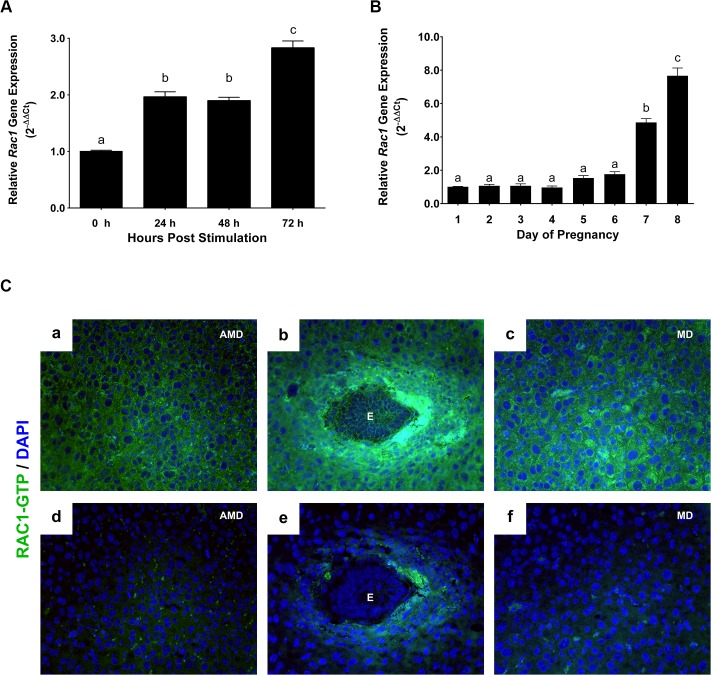
Rac1 is induced in the uterus during early pregnancy.
(A) Induction of Rac1 mRNA in the uterus during experimentally-induced decidualization. Uterine RNA was purified from mice at different times after decidual stimulation and analyzed by qPCR. Relative levels of Rac1 mRNA expression in uteri after decidual stimulation are compared to those in unstimulated control uteri. Data represent mean ± SEM from three separate samples and were analyzed by one-way ANOVA with Bonferroni post-test. Letters indicate statistically significant differences (P < 0.0001). (B) Expression of Rac1 during early pregnancy overlaps with the decidual phase of gestation. qPCR was performed to monitor the expression of Rac1 mRNA in uteri on days 1 to 8 of gestation. The relative levels of gene expression on different days of pregnancy were determined by setting the expression level of Rac1 mRNA on day 1 of pregnancy at 1.0. Rplp0, encoding a ribosomal protein, was used to normalize the level of RNA. Data represent mean ± SEM from three separate samples and were analyzed by one-way ANOVA with Bonferroni post-test. Letters indicate statistically significant differences (P < 0.0001). (C) Localization of active RAC1 protein in uterine stromal cells during early pregnancy. Uterine sections on day 7 of pregnancy were subjected to immunofluorescence (IF) histochemistry using anti-RAC1-GTP antibody. Panels a, b, and c show immunostaining of RAC1-GTP; panels d, e, and f show staining with non-immune IgG. AMD, MD and E indicate antimesometrial decidua, mesometrial decidua and embryo, respectively.